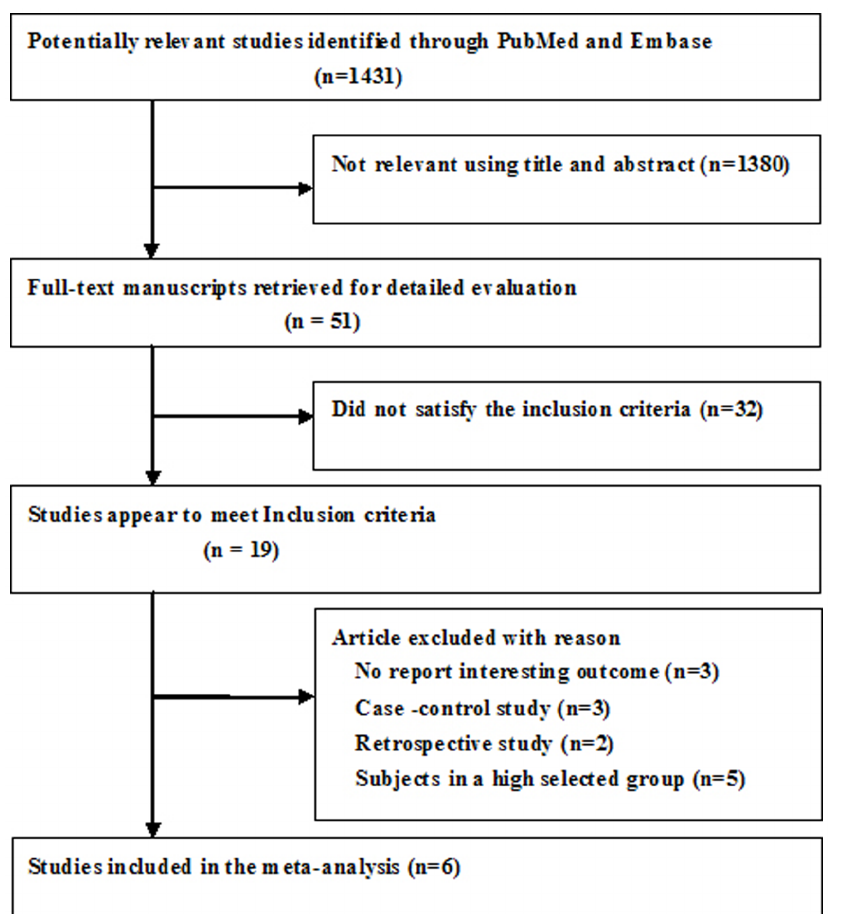
Figure 1. Flow chart of study selection process for meta-analysis.